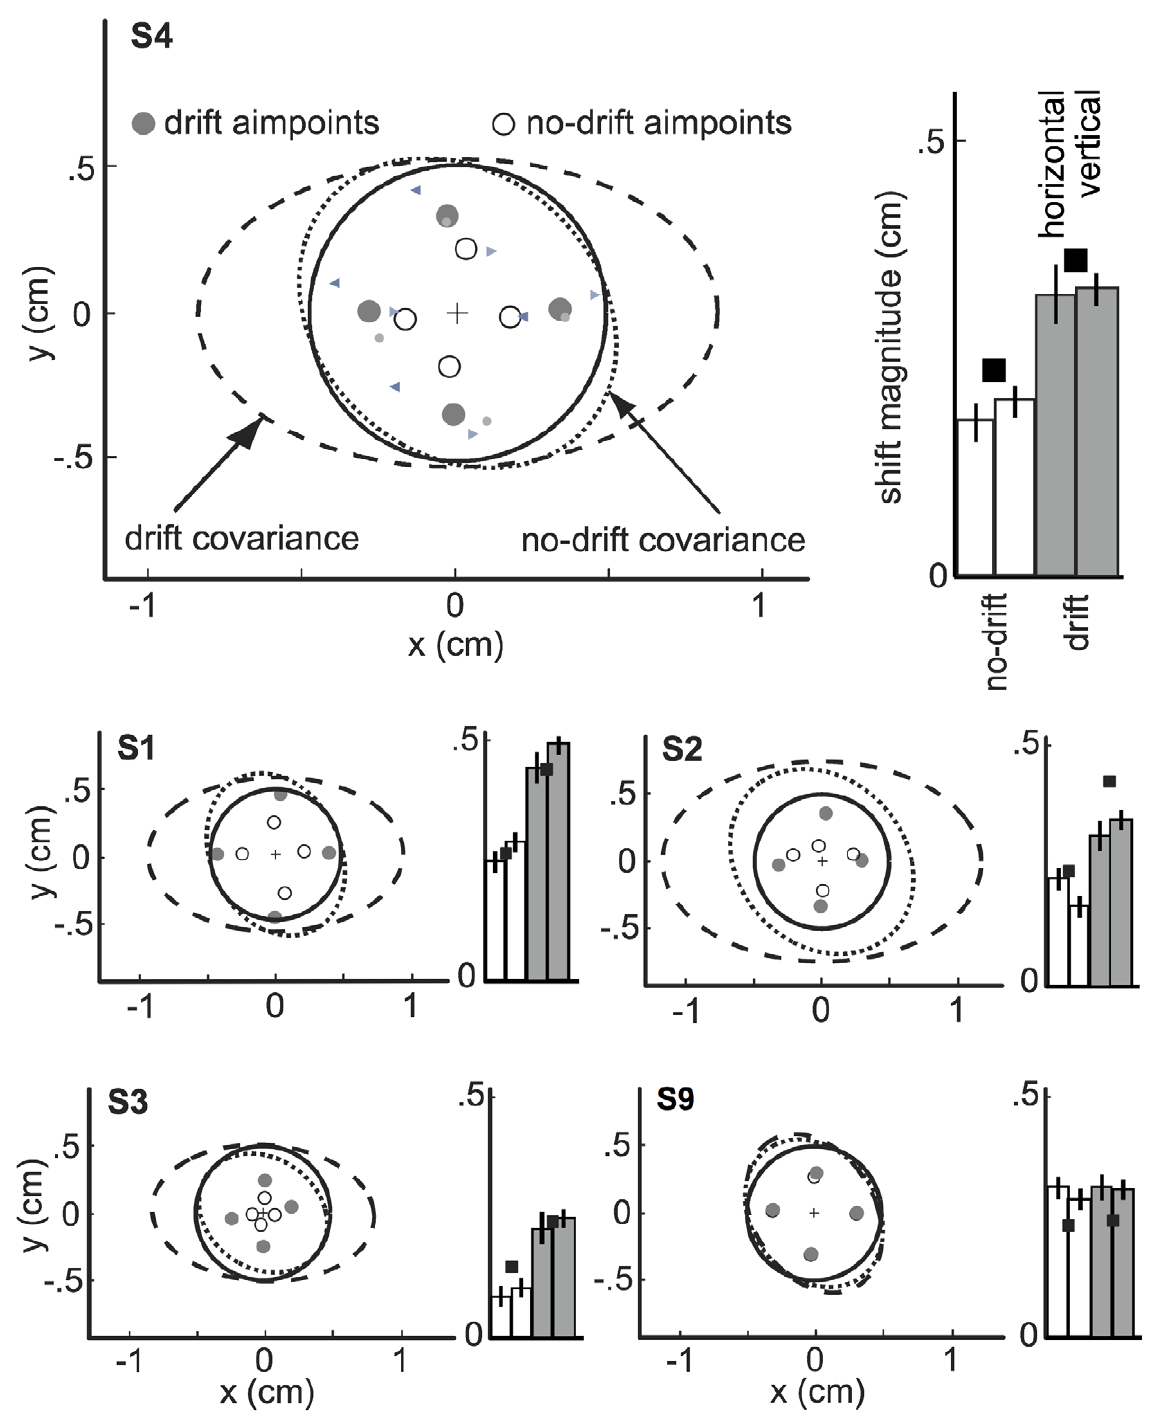
Figure 3. Mean endpoints and D aim values. Top graph, left: The solid circle is the target region. Dotted and dashed ellipses are 2-SD covariance ellipses of endpoints in the no-drift and drift conditions, respectively. Open and filled circles are the mean endpoints in the no-drift and drift conditions, respectively. Mean endpoints on the left correspond to trials with penalty to the right of the target, endpoints below correspond to penalty above, etc. Small symbols correspond to the subsets of trials for the three drift conditions as in Fig. 2. Top graph, right: Bars indicate average D aim values in the no-drift and drift conditions for horizontally and vertically displaced penalties. Black squares indicate predictions of the circular model ( M c ). All data for subject S4. Lower four graphs: same as above for S1, S2, S3, and S9.